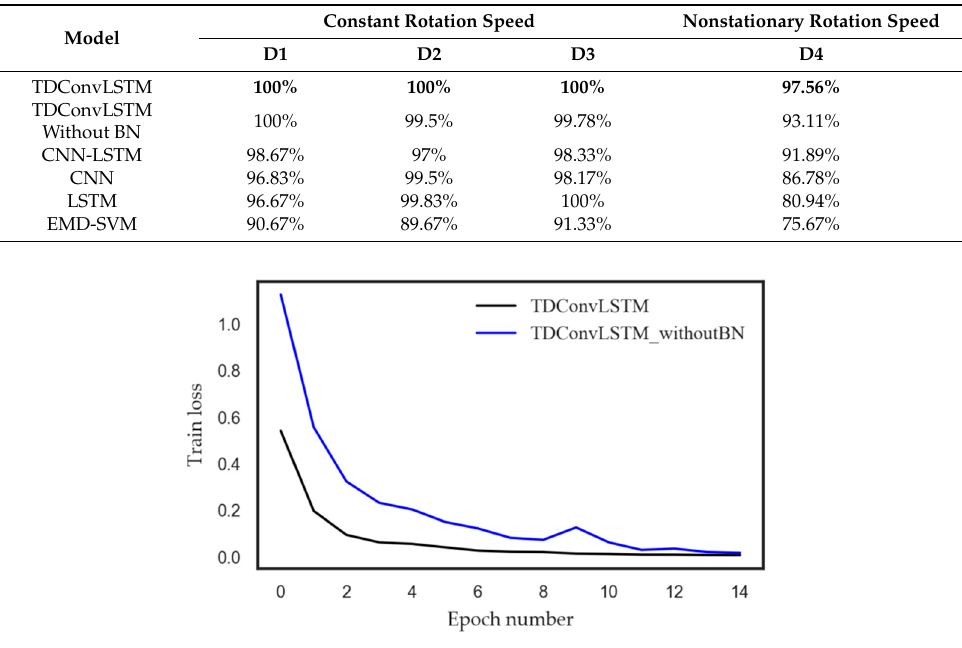
Table 3. Testing accuracy of comparative methods.